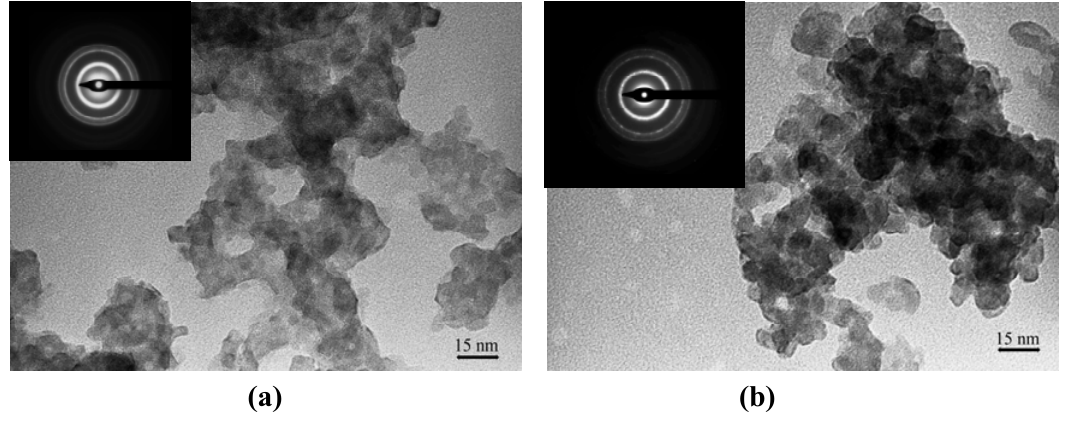
Figure 4. TEM images of (a) Ia and (b) IIa at mass composition of 1.0:1.0 (CdS: matrix, w/w) Insert: SAED images of CdS: matrix nanocomposites (a) Ia (b) IIa at mass composition of 1.0:1.0 (CdS: matrix,